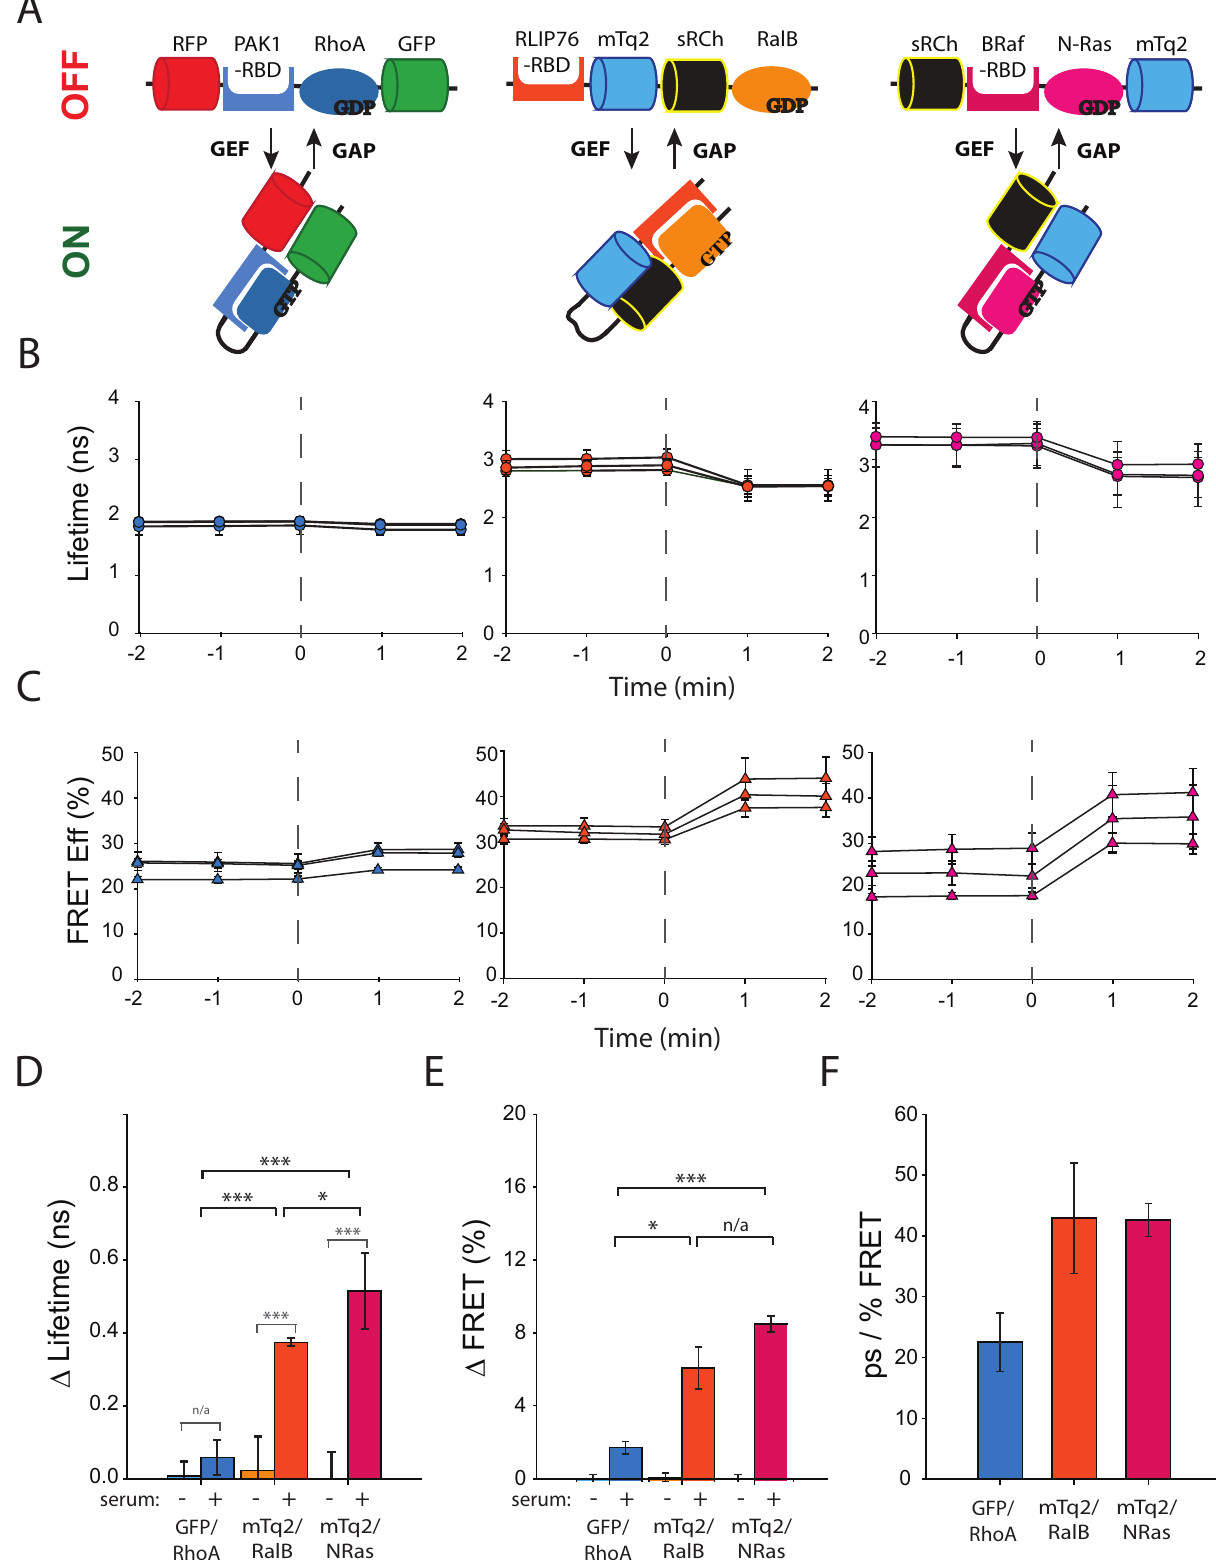
Fig 7. Comparison of an existing GFP-RFP GTPase Biosensor with novel mTq2-sRCh GTPase biosensors. A. Schematic representations of the GTPase biosensors tested: a GFP-RFP based RhoA-Raichu [43] (left); a new mTq2-sRCH based NRas-Raichu (right); and a modified version of an alternative PLOS ONE | https://doi.org/10.1371/journal.pone.0183585 January 2,